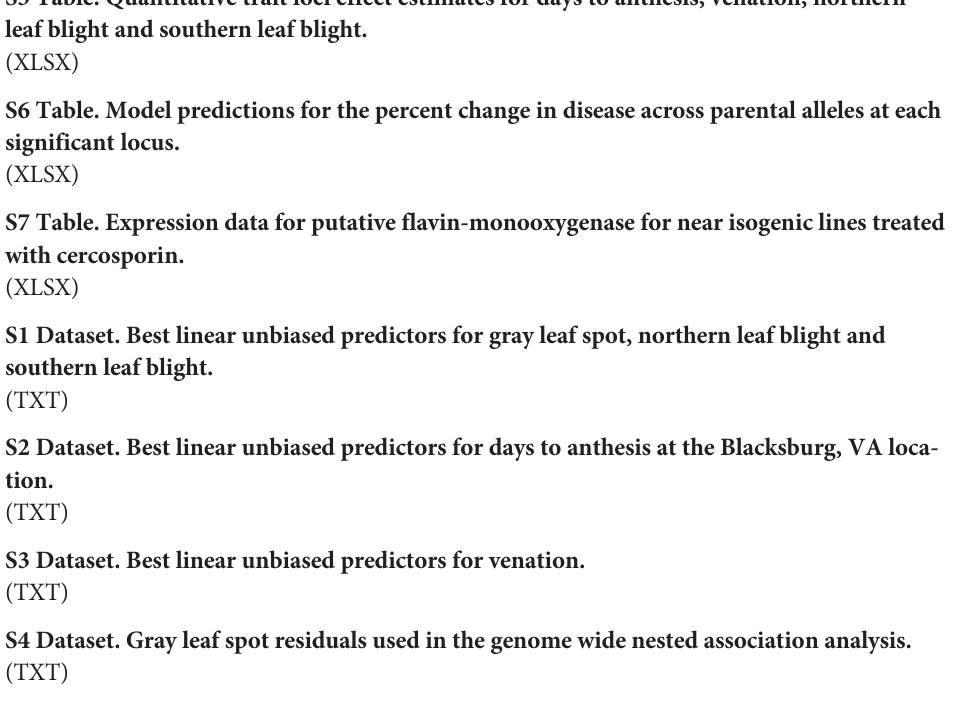
S1 Table. Genome wide association hits for resistance to gray leaf spot. Functionally anno- tated genome wide association hits. A 10 Kilobase window on either side of the GWA hit was screened for genes. Chr = Chromosome; BPP = Bootstrap posterior probability. S2 Table. Raw gray leaf spot data collected on the nested association mapping population. S3 Table. Raw venation data collected on nested association mapping population. S4 Table. Inter-vein distance and associated conidiophore count for nested association mapping parental line leaf tissue samples. S5 Table. Quantitative trait loci effect estimates for days to anthesis, venation, northern leaf blight and southern leaf blight. S6 Table. Model predictions for the percent change in disease across parental alleles at each significant locus. S7 Table. Expression data for putative flavin-monooxygenase for near isogenic lines treated with cercosporin. (XLSX) S1 Dataset. Best linear unbiased predictors for gray leaf spot, northern leaf blight and southern leaf blight.